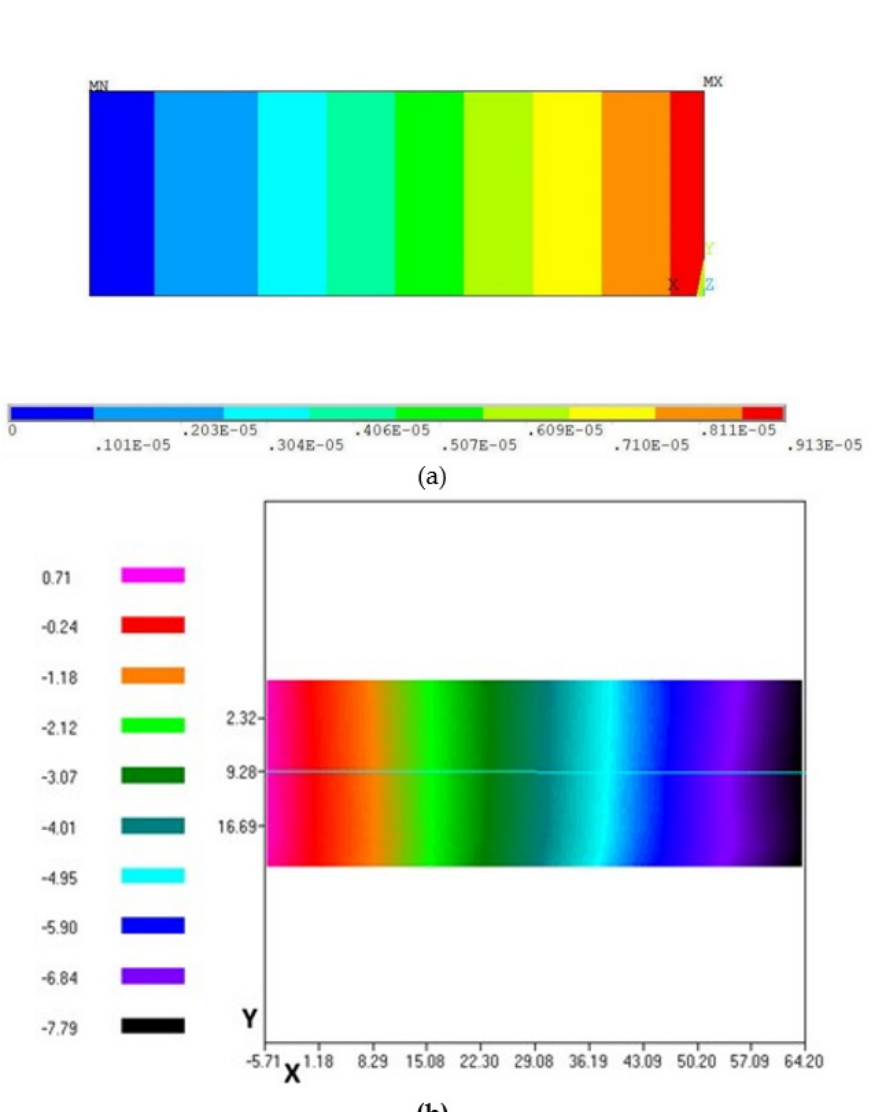
Figure 10. Transverse deflection surface distribution in ( a ) nonlinear FE simulation and its comparison to the ( b ) ESPI under applied voltage of 198 V.